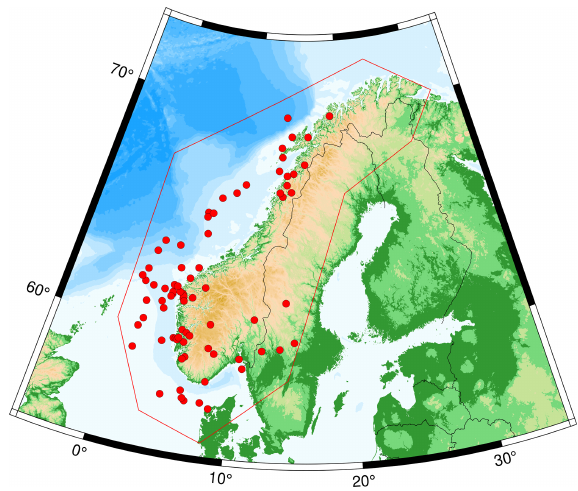
Figure 3. Earthquakes with M ≥ 4.5 near the Norwegian main- land in the period 1800–2021CE, which are checked for reports of EQILs. The red polygon outlines the area within which the earth- quake search was